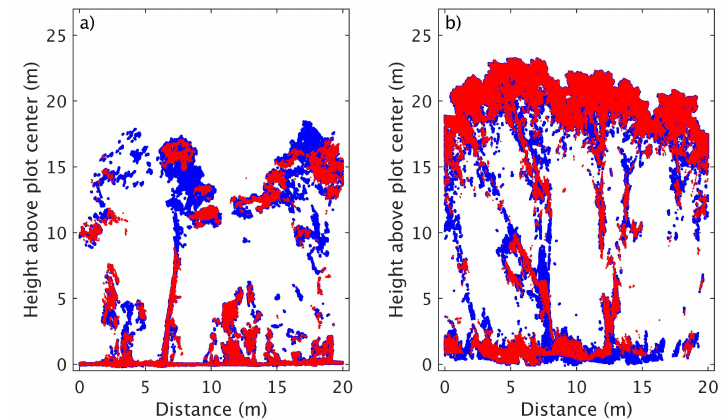
Figure 2. Point clouds generated with the nadir (red) and composite (blue) image sets at the ( a ) ENS01 and ( b ) ENS02 sites. The point clouds are shown for a 1.5m wide transect passing through the centre of the point cloud.